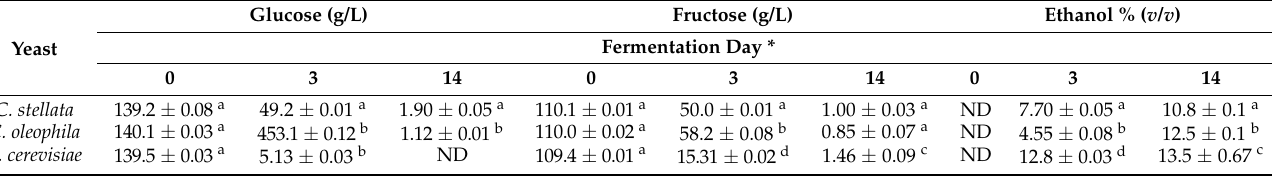
Values represent mean ± standard deviations for two independent sets and three replicates ( n = 6). Different lower-case superscript letters within columns indicate significant differences ( p < 0.05). * Non- Saccharomyces yeasts were single inoculated at time point 0, and after 3 days, S. cerevisiae was inoculated into the fermentation